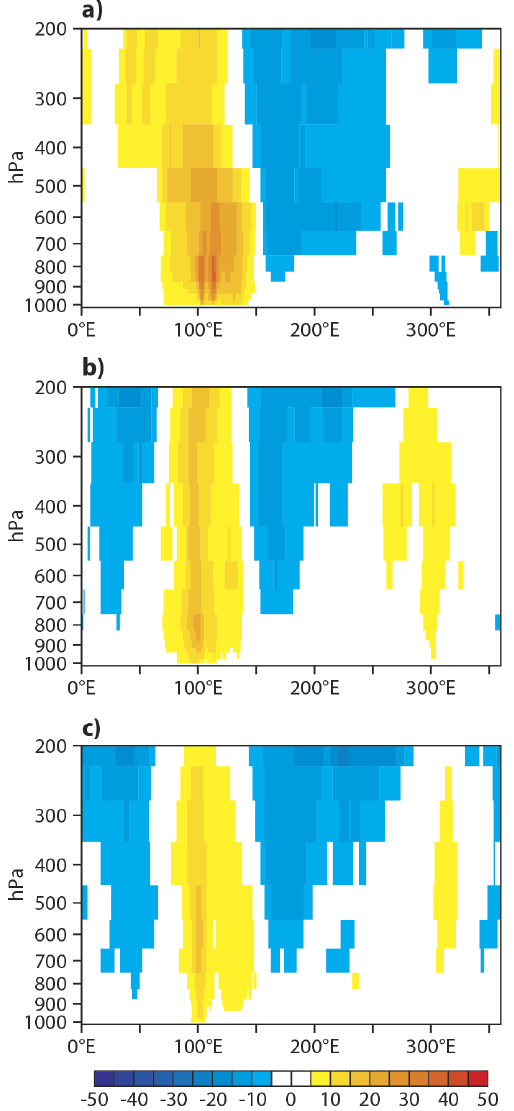
Figure 9. Vertical cross section of O 3 anomalies in ppb plotted against longitude and averaged between 0 ◦ and 12 ◦ S calculated from the MACC reanalysis as the difference of El Niño composite minus La Niña composite for October (a) , November (b) and De- cember (c) . Red colours indicate positive values and blue colours negative values.